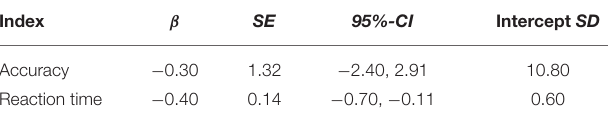
TABLE 4 | LME analysis—short-term memory performance and cvRMSSD.